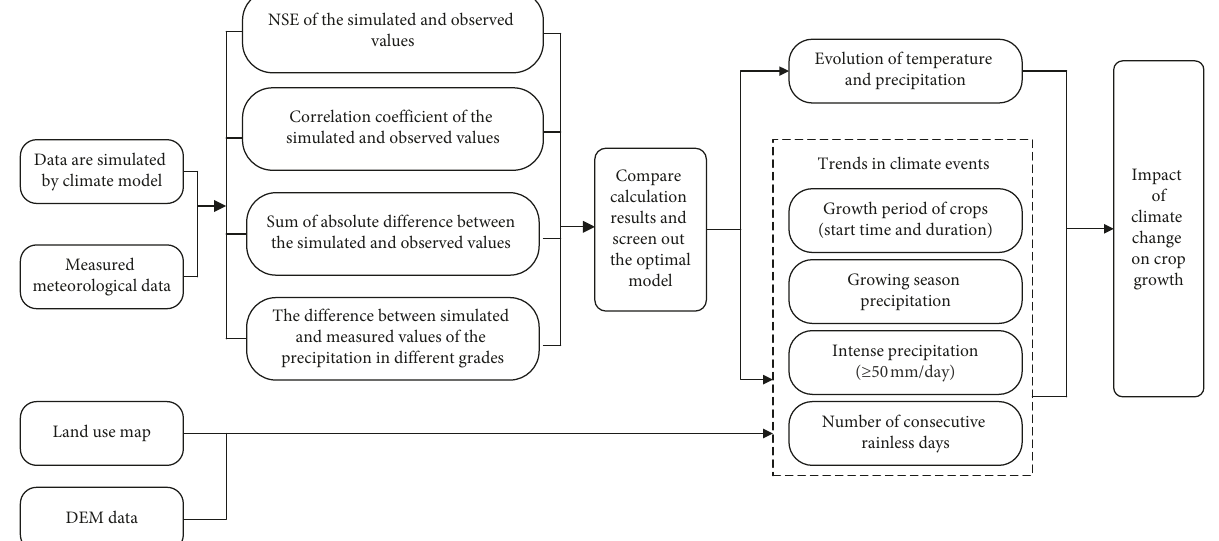
Figure 2: Technical steps for the study. Note: NSE represents the Nash–Sutcliffe efficiency